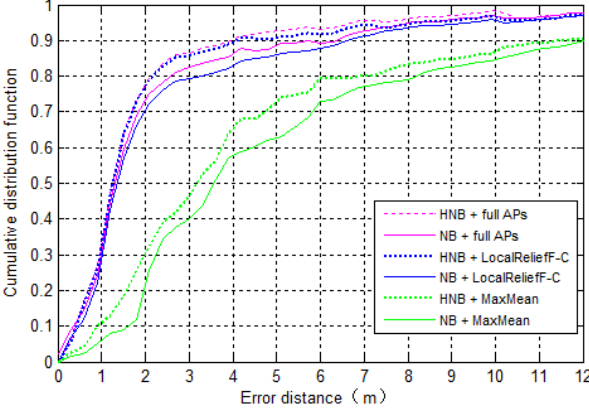
Figure 15. Precision comparison of location estimation methods.